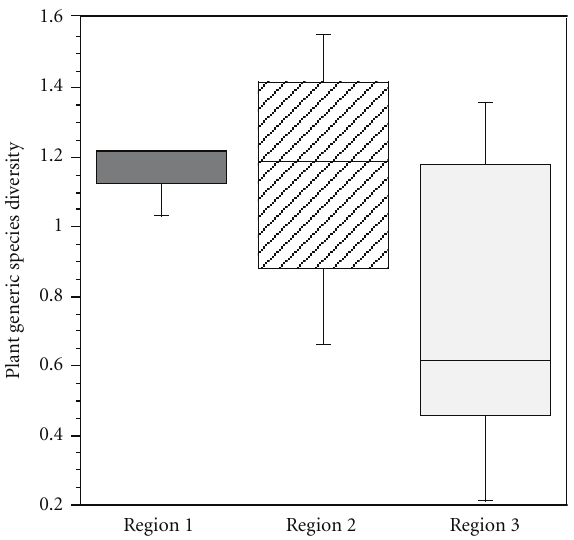
Figure 4: Median, range, and upper and lower quartiles of generic species diversity of plants from which bumblebees were collected along the edge of blueberry fields in three regions in Maine. Based on a subset of 13 fields. Region 1, n = 3; Region 2, n = 4; Region 3, n = 6.